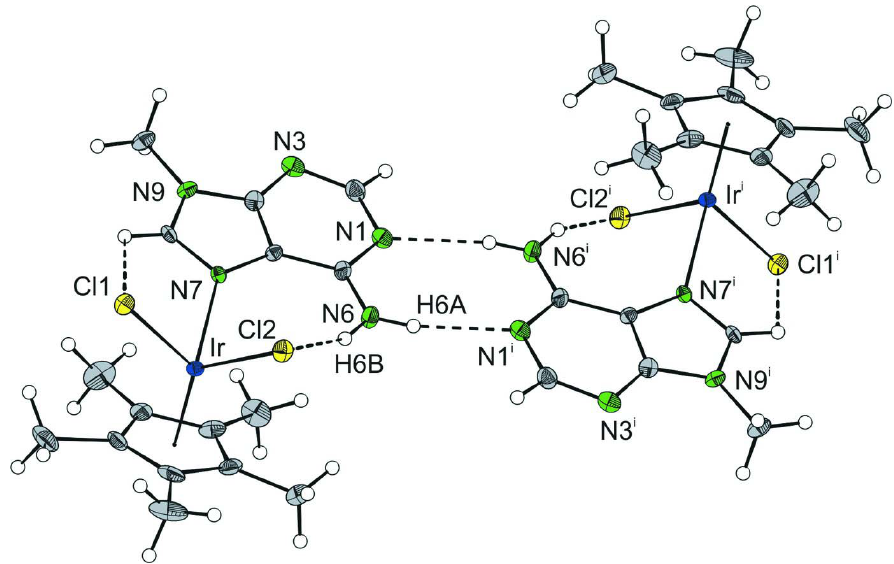
Figure 2 Structure of the dinuclear complex [{IrCl ellipsoids are drawn at the 30% probability level and H atoms are shown as small spheres of arbitrary radii. The numbering scheme of the C atoms is as shown in Figure 1. Symmetry codes: (i) – x + 2, – y , – z +